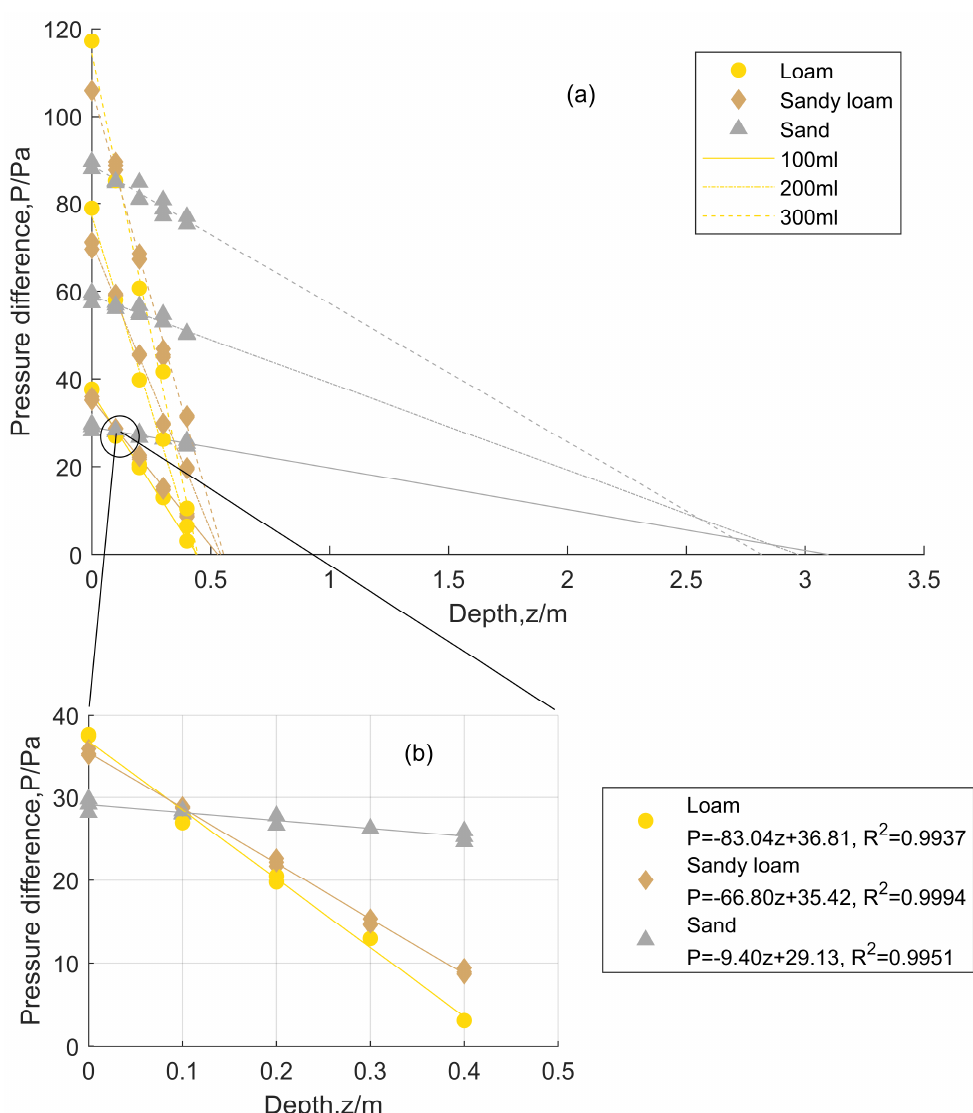
Figure 3. ( a ) Relationship between the pressure difference in the porous medium of the three soils and the depth of transmission ( b ) Propagation depth of the pressure in the three soils in the case of pumping 100 mL, 200 mL and 300 mL, the pressure difference caused by 1P-100 mL, the pressure difference formed by 2P-200 mL and the pressure difference formed by 3P-300 mL.